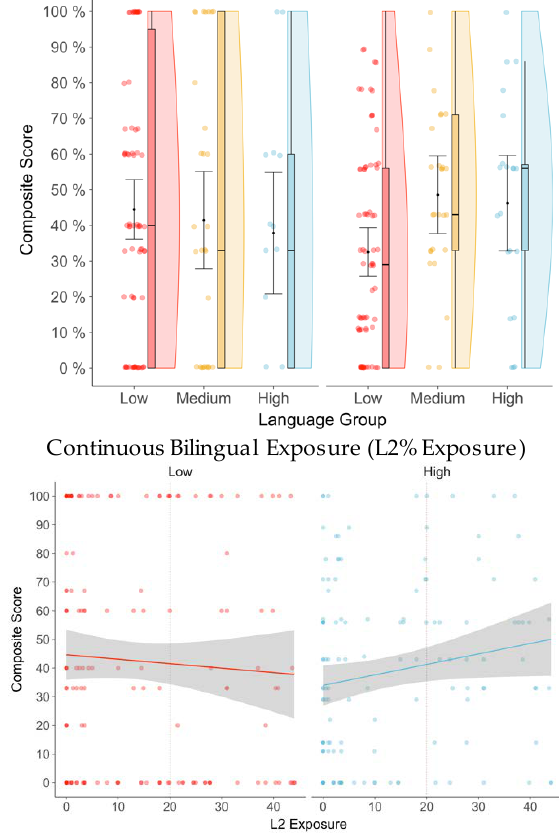
Figure 5. Exploratory Analysis Measuring Load and Language Exposure. Three approaches to measuring language exposure were used: a binary classification of Monolinguals and Bilinguals (Top Panel), profiles using a Latent Profile Analysis approach (Middle Panel), and bilingualism as a continuum using the L2 percent exposure as a proxy (Bottom Panel).